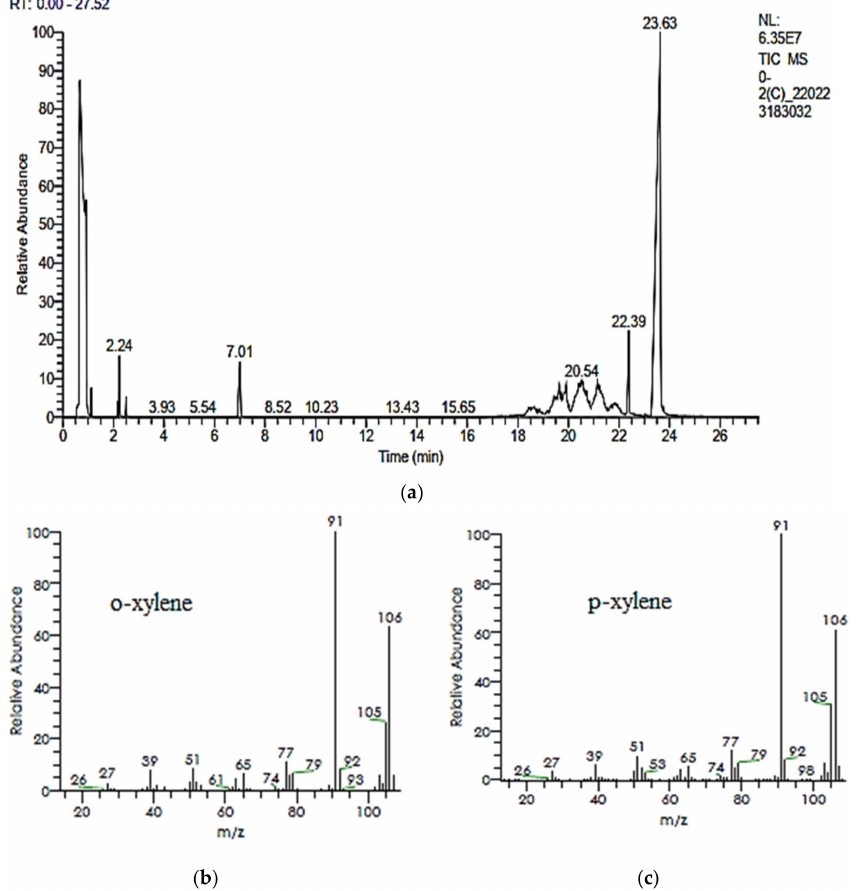
Figure 15. GC chromatogram of Basic Orange 2 dye: ( a ) after bacterial degradation; ( b , c ) ma- jor